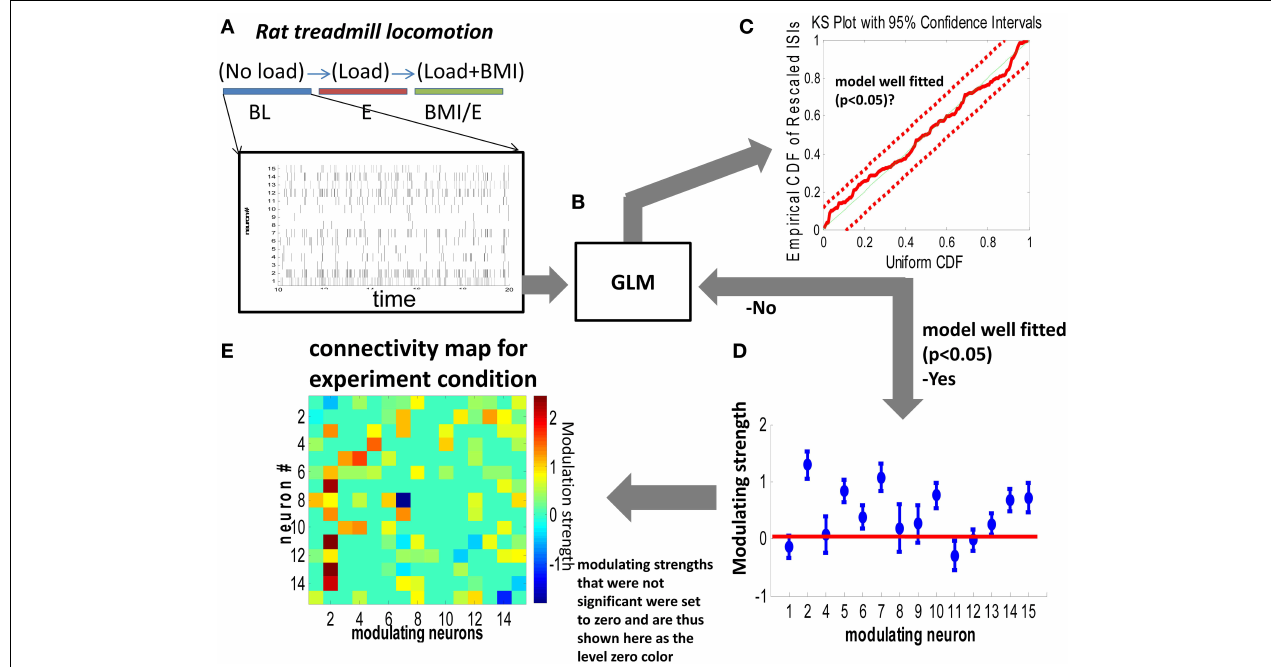
be independent, identically distributed, exponential random variables with unit rate. (D) For neurons which showed a significant nonzero contribution in the GLM model, the nonzero modeling strength was used to construct an element in the connectivity matrix (map) in (E) . Parameters whose confidence interval crossed zero (the horizontal red line) in (D) were deemed not significantly different from zero and were set to zero in the connectivity maps in (E)